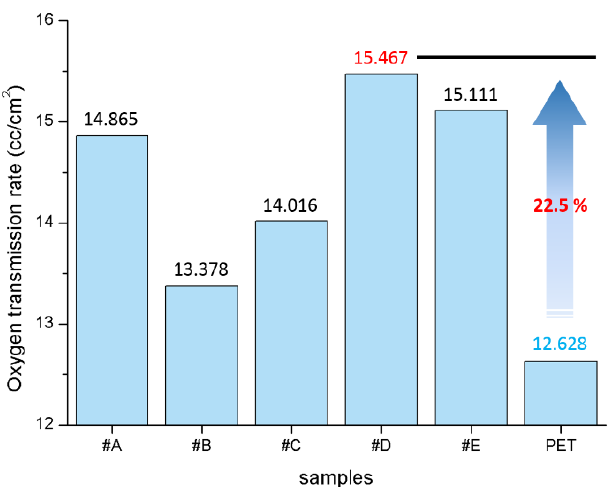
Figure 2. Oxygen transmission rate according to combination ratio of polydimethylsiloxane